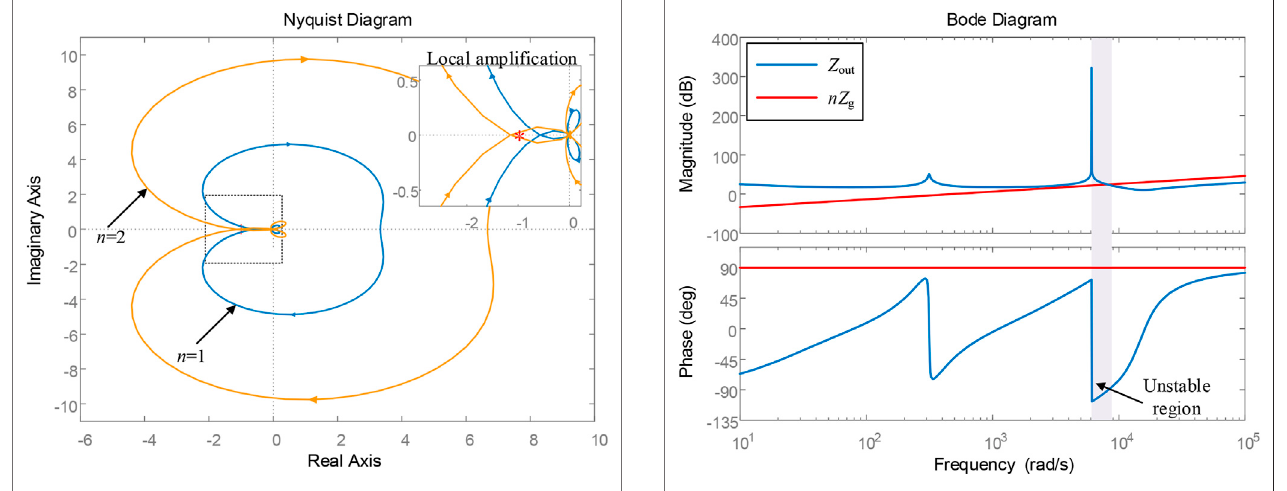
FIGURE 4 | Nyquist curve of impedance ratio. FIGURE 5 | Bode diagram of inverter output